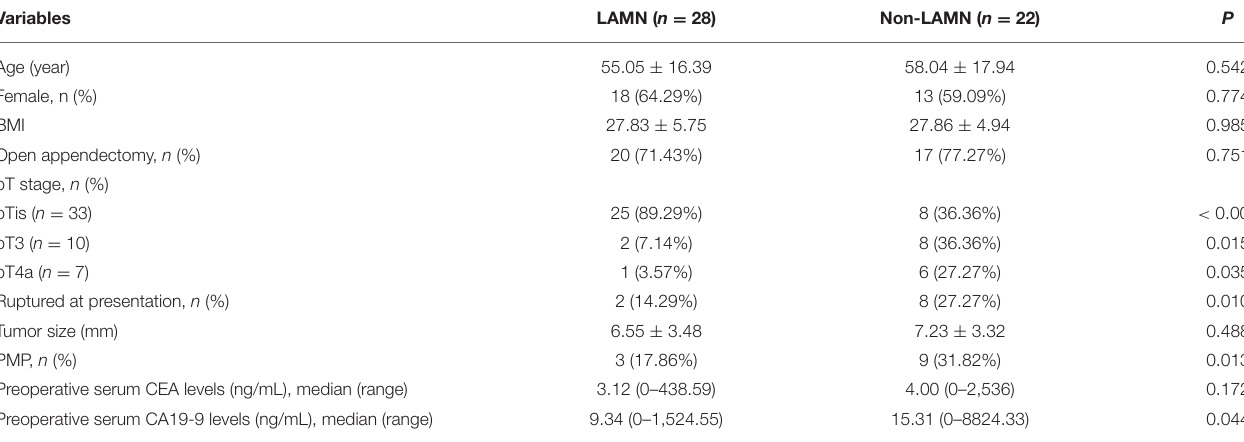
TABLE 1 | Demographics, surgical management, tumor characteristics of patients stratified by LAMN and non-LAMN classification. Variables